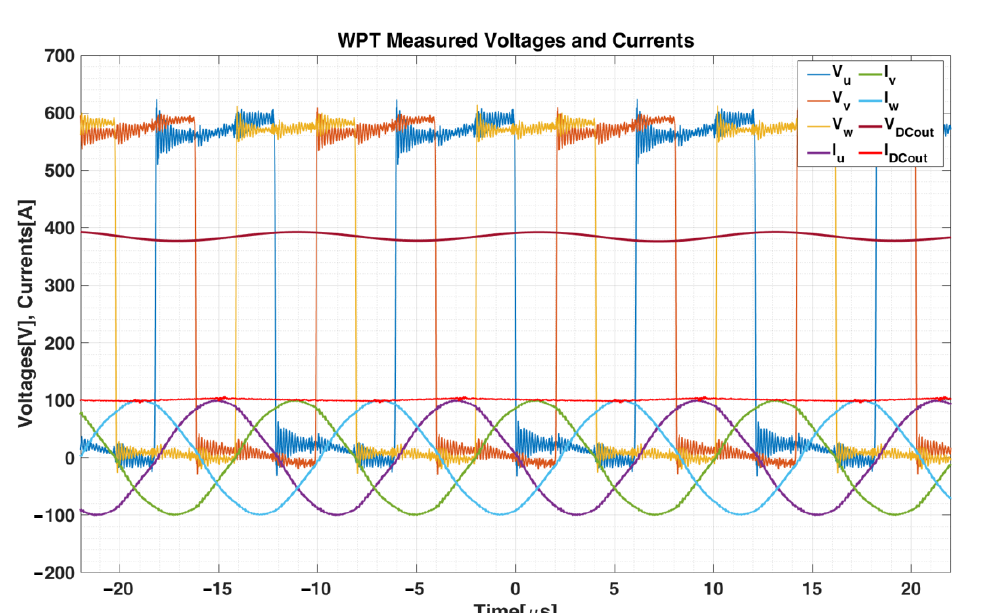
Figure 11. Measured phase voltages ( V u , V v , V w ) and phase currents ( V u , V v , V w ) ( I u , I v , I w ) on the primary side of WPT unit and measured voltage ( V DCout ) and current ( I DCout ) at output DC terminals of the WPT